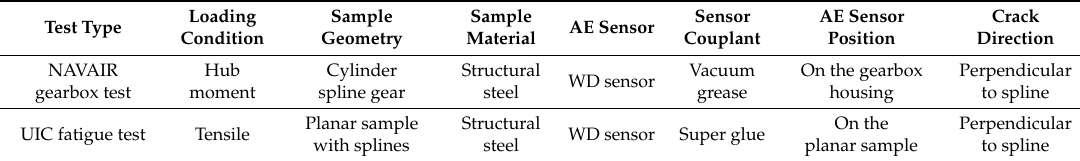
Table 1. The comparison of Naval Air Systems Command (NAVAIR) gearbox test and UIC fatigue test. Test Type Test